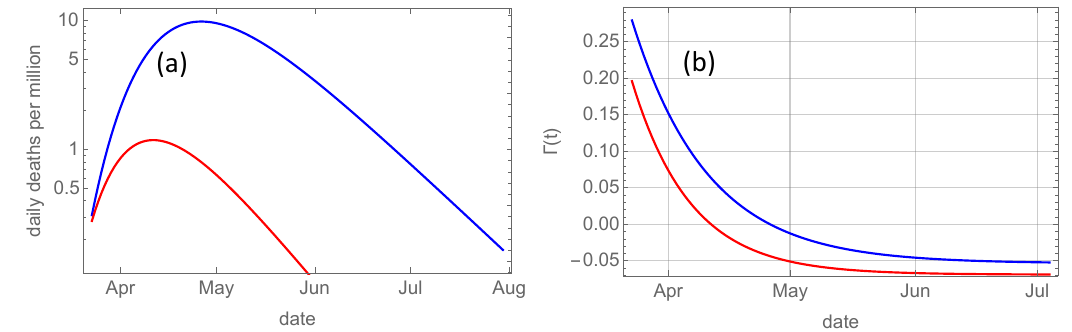
Figure 3. ( a ): Evolution of daily deaths per million, dJ / dt , computed numerically from Equation (12) for Norway (red) and for Sweden (blue). ( b ): The relative growth rate Γ ( t ) = d t ( ln d t J ) for Norway (red) and for Sweden